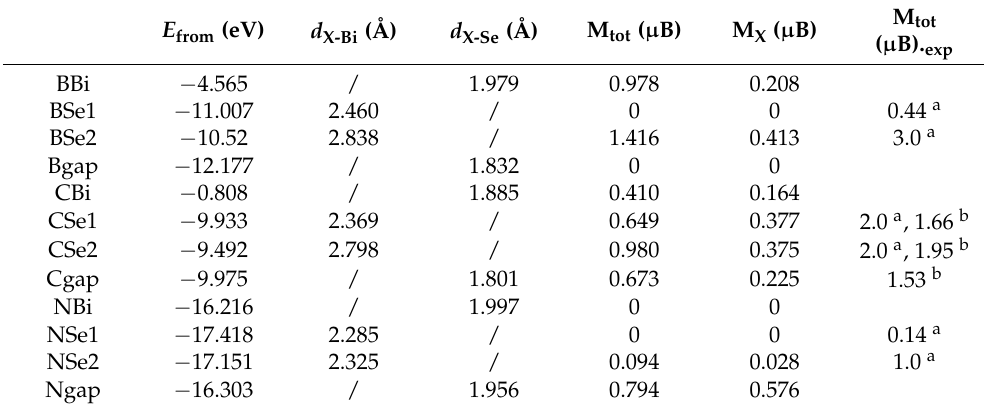
Table 1. Formation energies, bond lengths and magnetic moments of X doping Bi 2 Se 3